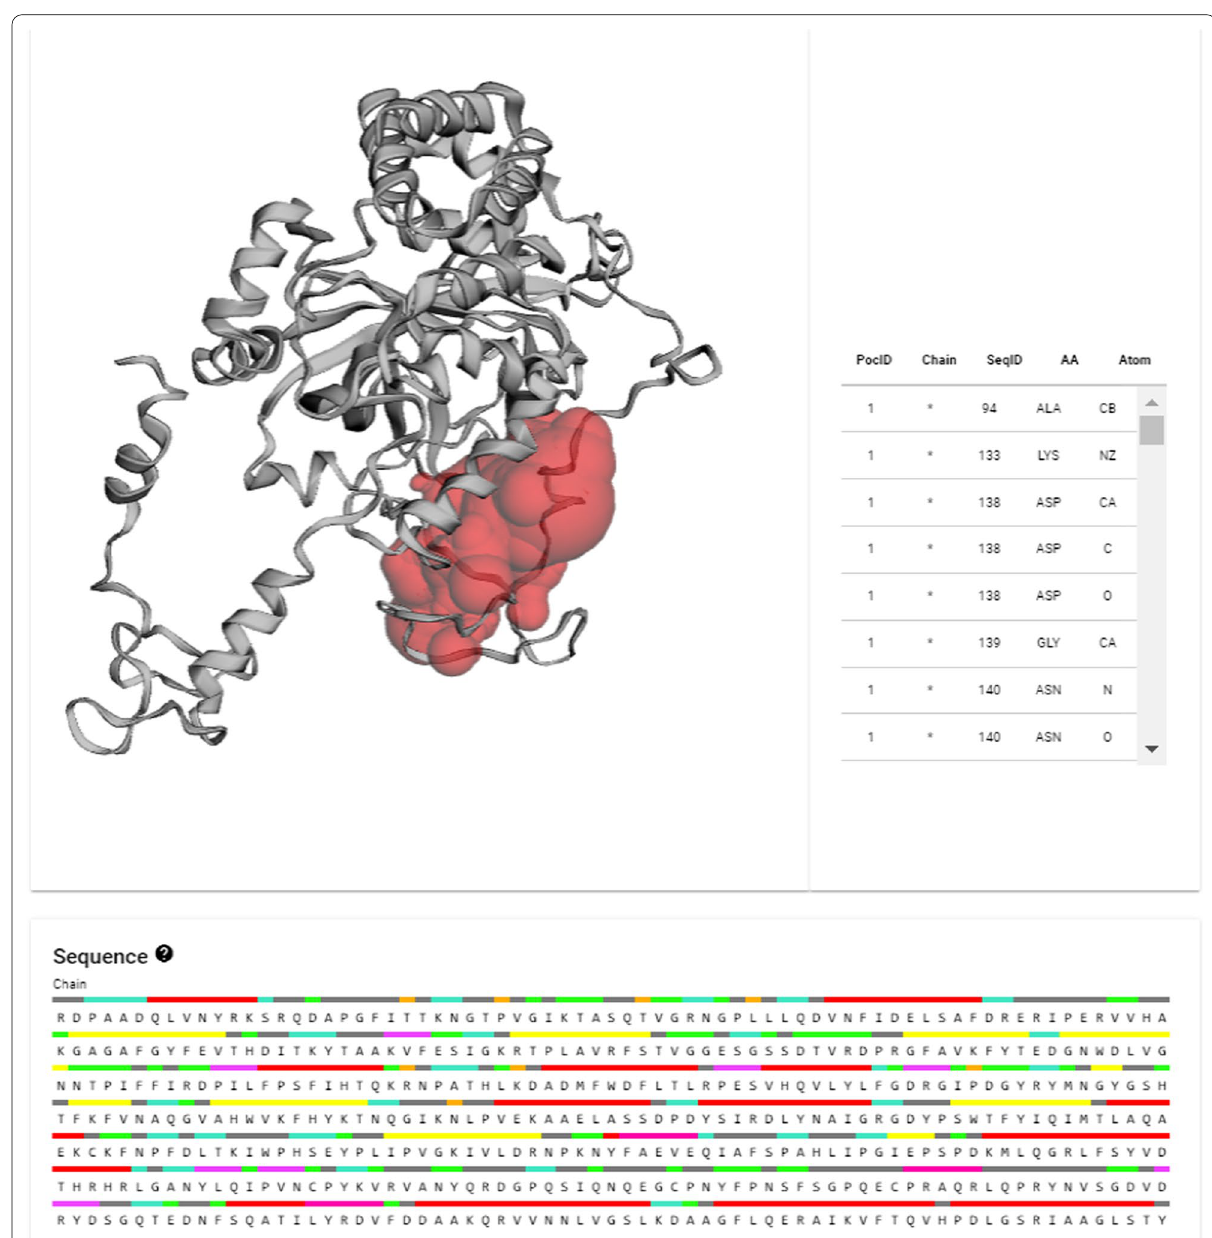
Fig. 10 Active sites of G. mellonella